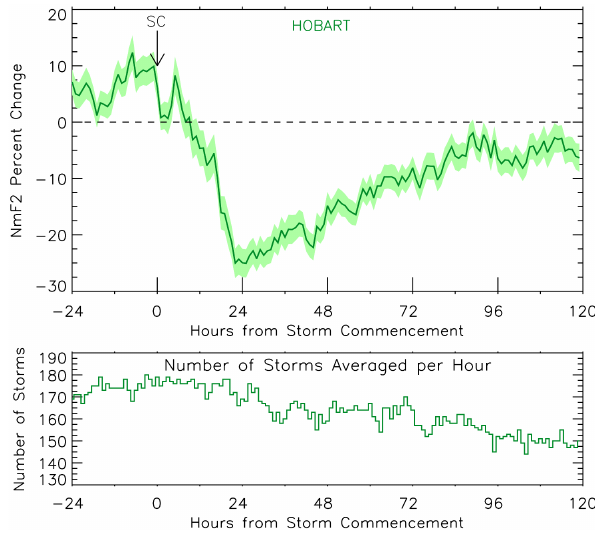
Fig. 4. Average storm-time patterns for 1 Nm F2( τ , %) at Hobart. The shading gives the error of the mean (see text) at each storm- time hour. The lower panel gives the number of storms (from the total of 206 possible) used to form the pattern given. To illustrate the difference between the standard deviation ( σ) and the error of the mean ( σ M ) , σ =± 42.53% at the peak of the positive phase ( τ =5h), and σ =± 31.69% at the peak of the negative phase ( τ =25h). At these times, σ M =± 3.29% and ± 2.48%,